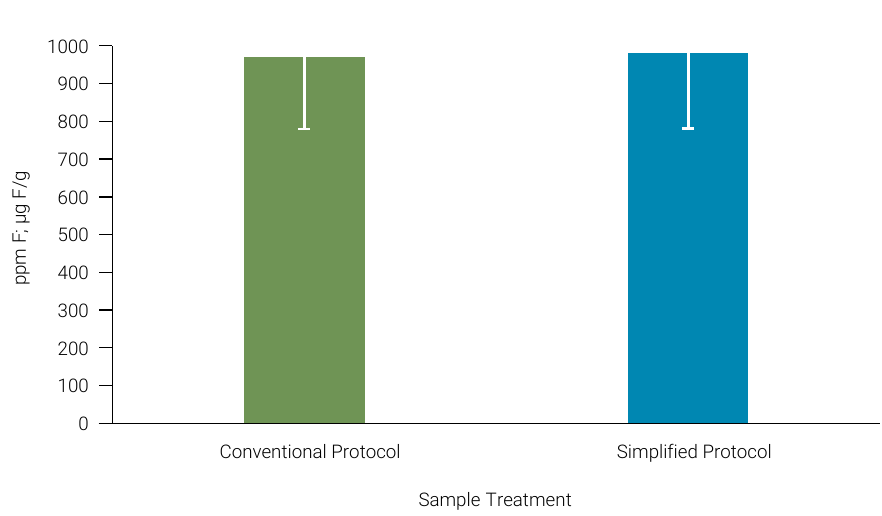
Figure 4. Fluoride concentration (ppm F) found in the toothpastes by the conventional (Ac + ) and the simplified (Ac - ) protocol;